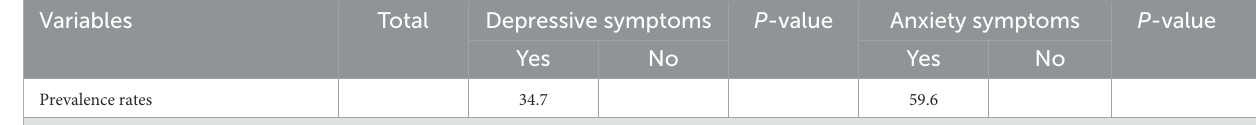
TABLE 1 Characteristics of the participants in the study ( N =